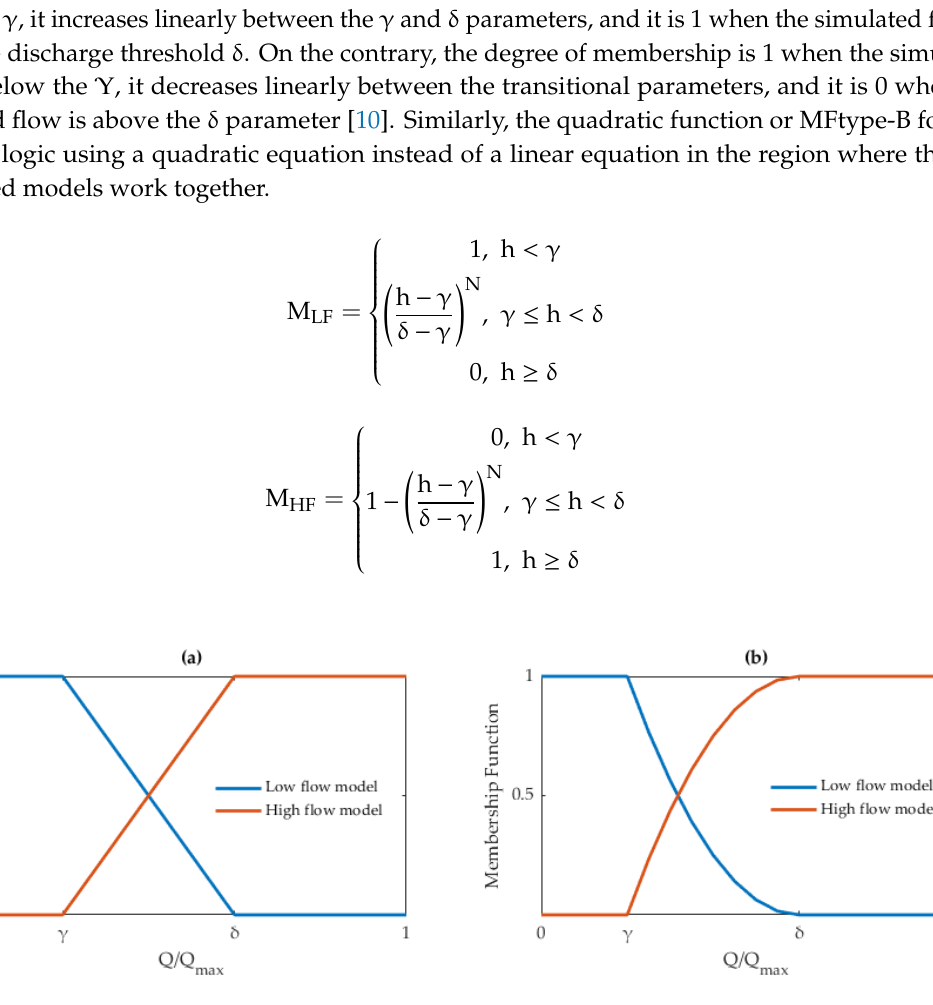
Figure 4. Fuzzy membership functions for combining local models. ( a ) Trapezoidal membership function (MFtype-A), ( b ) a quadratic membership function (MFtype-B) for high and low flow models. Reproduced with permission from Kayastha et al., Hydrology and Earth System Sciences; published by Copernicus Publications on behalf of the European Geoscience Union, 2012 [11].